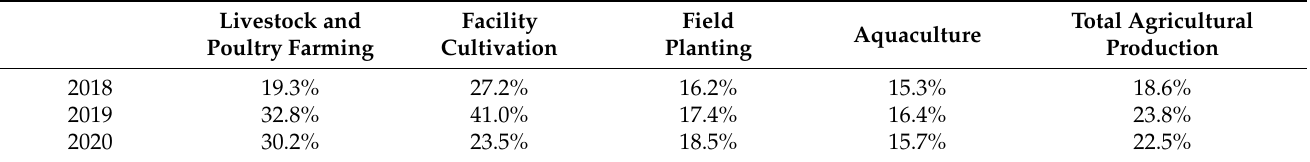
Table 1. Agricultural production informatization levels in 2018–2020.